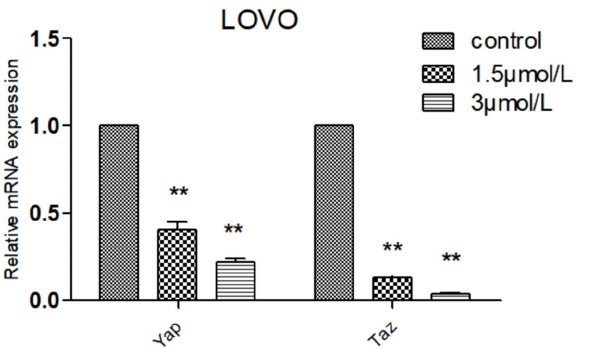
Figure 11. The effect of DTB on the expression of YAP and TAZ related genes of the LOVO Hippo pathway in colon cancer cells. n = 3; compared with the blank group, ** p < 0.01, each data point represents the mean ± standard error.